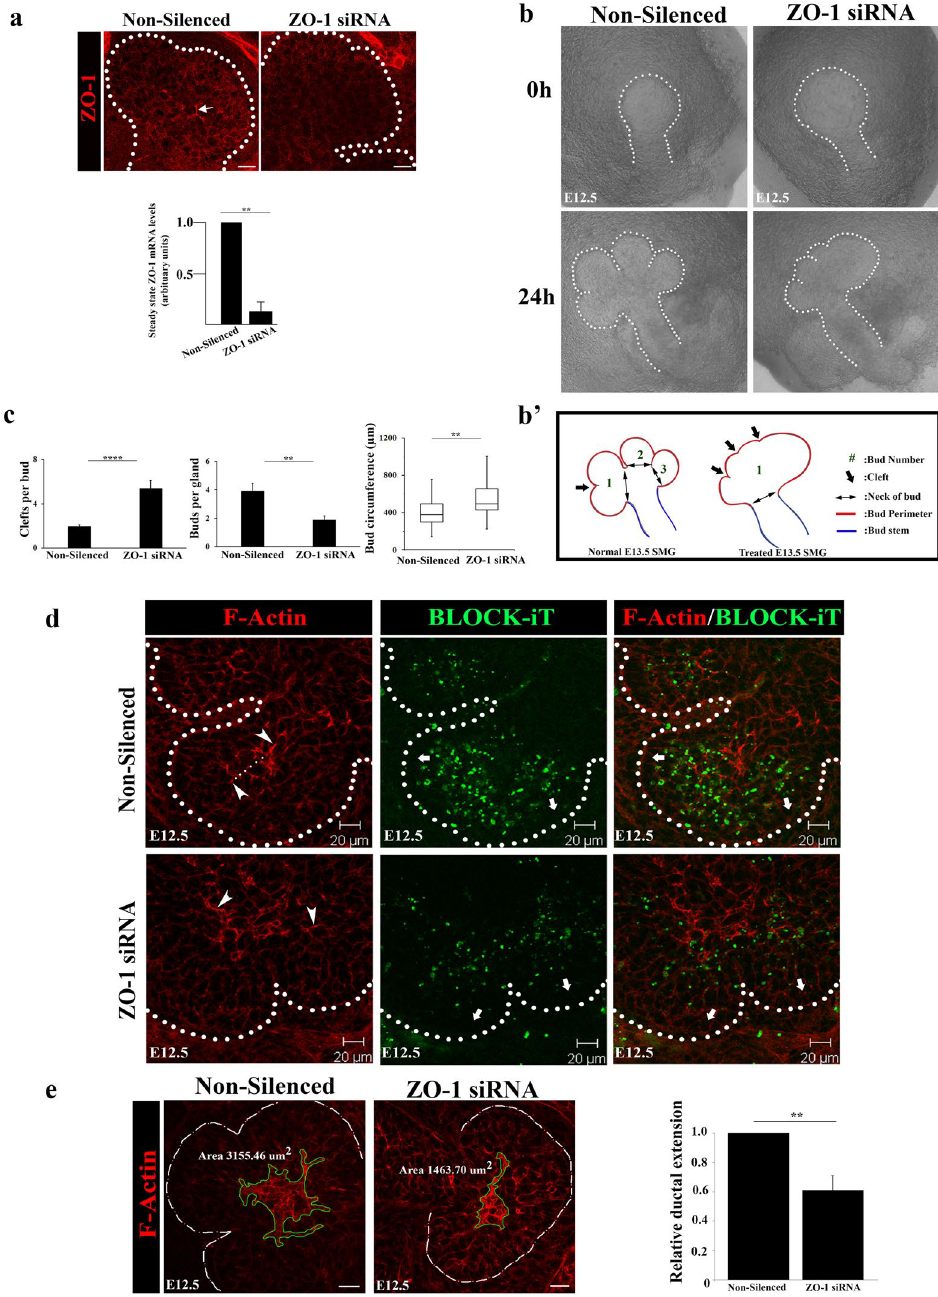
Figure 3. ZO-1 maintains F-actin at the sites of asymmetry and is required for duct extension early in SMG development. ( a ) Immunofluorescence staining of ZO-1 ( → ) in E12.5 SMG following ZO-1 knockdown with siRNA revealed loss of ZO-1- specific staining (n = 16). Bar graph of siRNA-mediated inhibition of ZO-1 in E12.5 SMG showed a significant, more than 80%, knockdown of the ZO-1 transcript levels ( p ≤ 0.01). ( b ) Bright field images in Non-silenced (scrambled sequences) and ZO-1 siRNA-treated SMGs show inhibition of cleft progression and gland expansion. ( b’ ) A schematic of observed changes in bud morphologies used for quantification of ZO-1-inhibited glands in ( c ), with marked ( → ) clefts and maturing buds. ( c ) Quantification of defects in branching morphogenesis following ZO-1 knockdown in E12.5 SMGs. Bar graphs and a box plot of non-silenced and ZO-1 siRNA-treated E12.5 SMGs revealed significant changes in gland morphologies, including increased number of clefts ( p ≤ 0.0001) along with reduced bud numbers ( p ≤ 0.01) and elevated bud circumference ( p ≤ 0.01) in ZO-1- inhibited glands. ( d ) Immunofluorescence images depict inappropriately bundled F-actin coincident with the loss of ductal extensions in the absence of ZO-1 ( → ). BLOCK-iT marks siRNA uptake by the SMG with paucity of siRNA in cells in the outer layers of buds with columnar morphologies ( ➔ ). ( e ) Quantification of the effects of ZO-1 siRNA on F-actin expansion (areas defined by green outlines) during ductal extension. Bar graph indicates significant ( p ≤ 0.01) reduction in the total area of F-actin upon ZO-1 inhibition. Size bars, 20